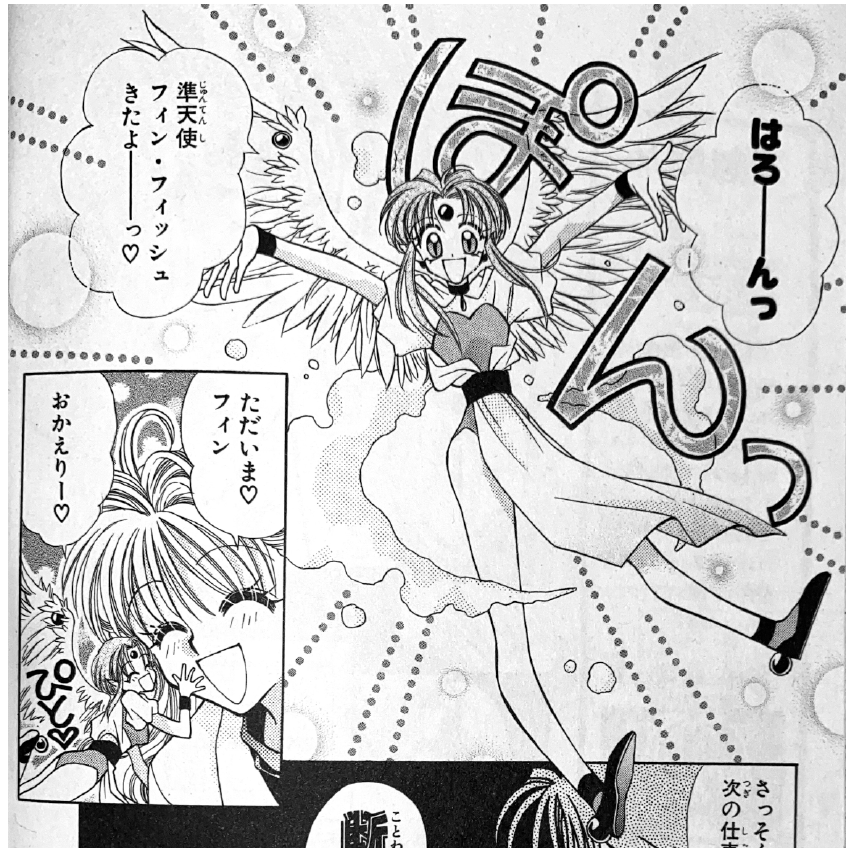
Figure 3 Image A of semi-angel Fin Fish when she first appears and is introduced as semi-angel to the reader (Tanemura